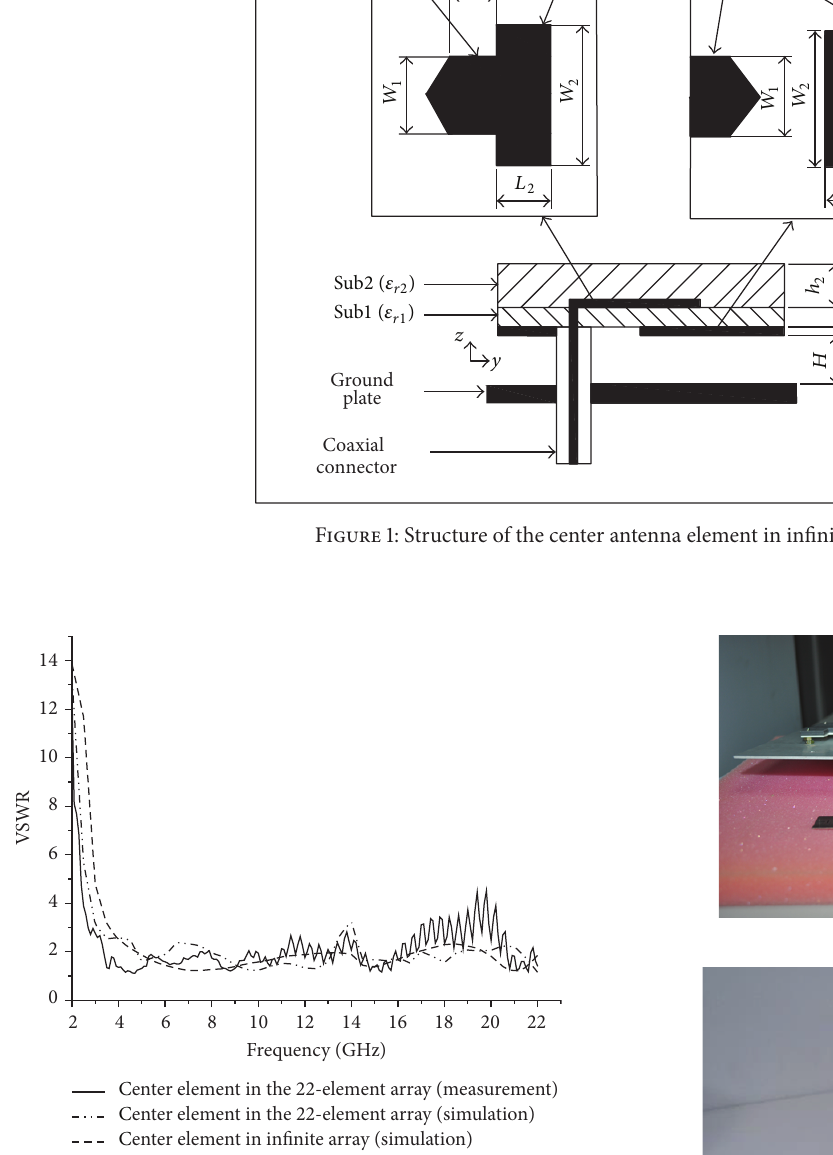
Figure 2: Simulated active VSWR of the center element in infinite array.